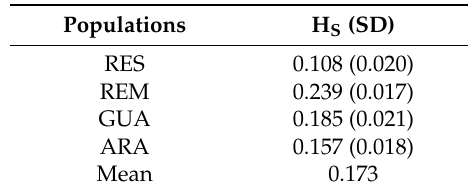
Table 2. Within-population genetic diversity index (H S ) calculated for the four studied populations of Laguncularia racemosa and the mean value. RES—restored plants in Mau á Beach; REM—remnant